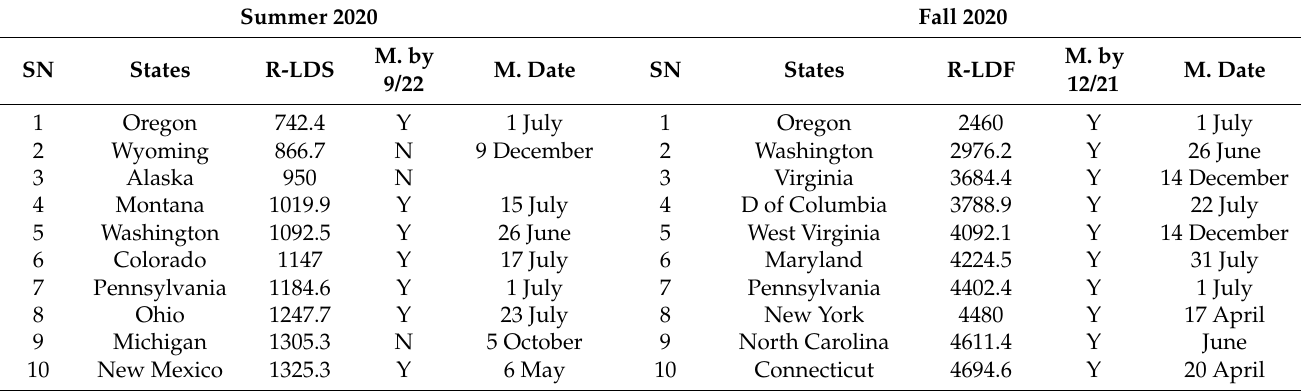
Table 2. Lowest summer and fall rates of confirmed COVID-19 infection cases.